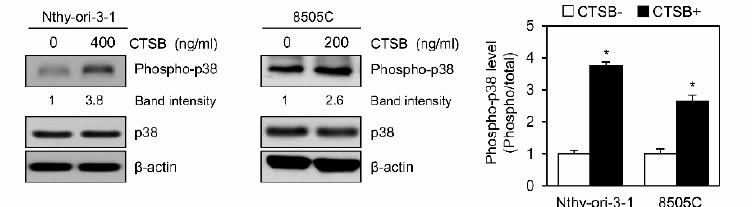
Figure 6. Treatment with recombinant CTSB induces p38 activation in normal thyroid epithelial and thyroid cancer cell lines. Phosphorylation of p38 was ascertained by immunoblotting. Nthy-ori-3-1 cells were treated with 400 ng/mL CTSB for 1 h while 8505C cells were treated with 200 ng/mL CTSB for 1 h. Intensity of phosphor-p38 bands were normalized to total p38 levels and were quantified using ImageJ software. The relative intensity of phosphor-p38 without CTSB was set to 1. Band intensity of phospho-p38 with the treatment of CTSB was analyzed as fold-change compared to no treatment of CTSB. Table for the relative levels of phosphor-p38 exposure to recombinant human CTSB. The relative level of phosphor-p38 was calculated and statistically analyzed. Data are representative of three experiments. * p < 0.05.